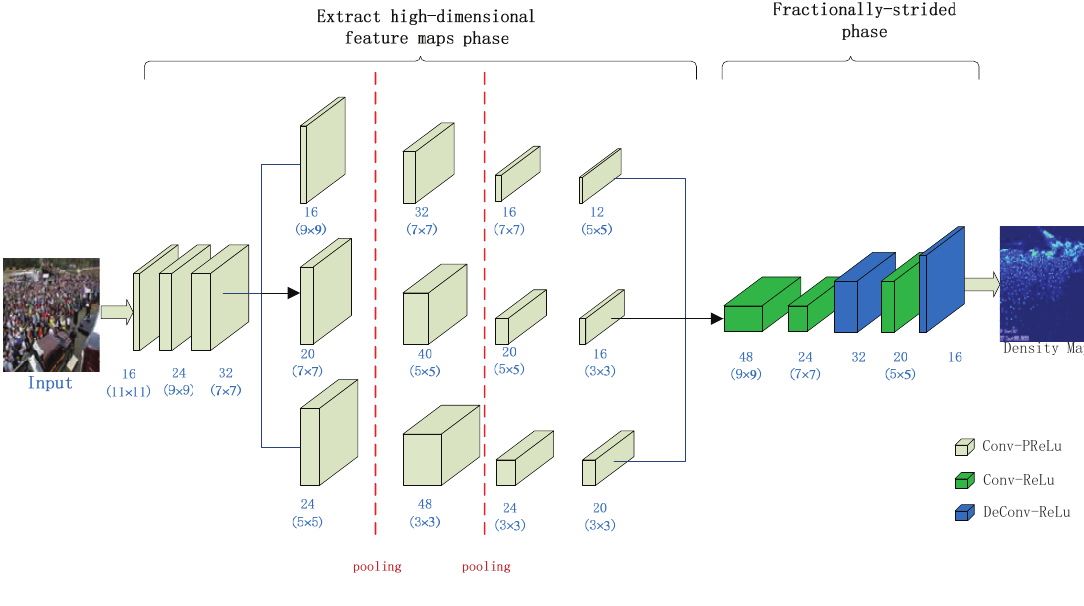
Figure 2: Generator stage: the first part is used to extract high-dimensional feature map, which is basically composed of con- volutional layer-PReLU (Conv-PReLU), pooling represents max-pooling layer, factor is 2; then the second is fractionally-strided convolutional phase, its basic composition is deconvolution-ReLU (DeConv-ReLU).